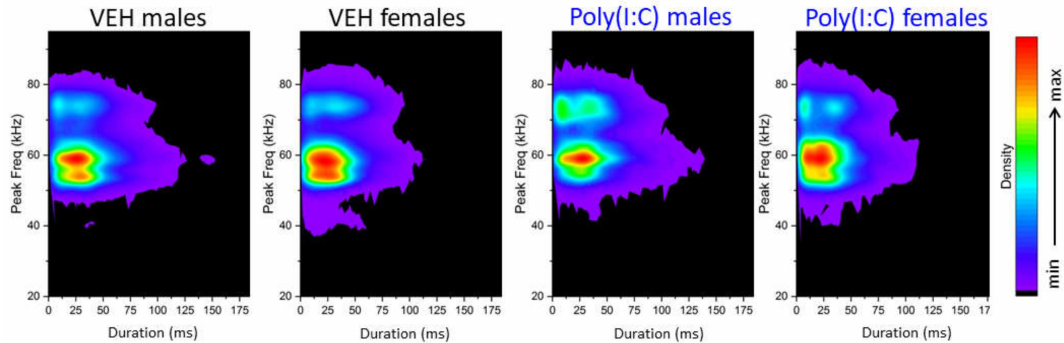
Figure 4. Density plots illustrating the distribution of individual calls depending on their peak frequencies versus durations in vehicle- and poly(I:C)-exposed rats. The densities were visualized in a color-coded way. Poly(I:C) did not change the overall USV cluster distributions, but an enhanced representation of high-frequency calls was observed for poly(I:C) animals.